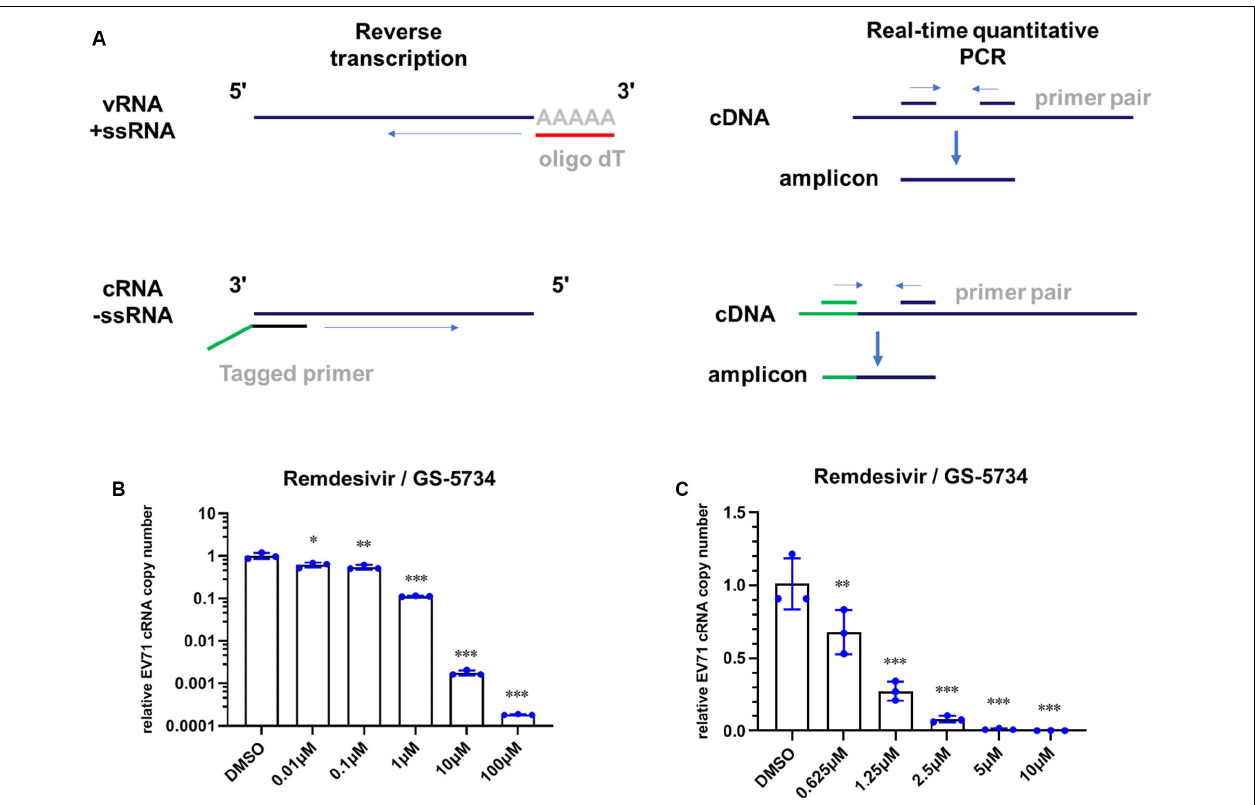
FIGURE 3 | Remdesivir inhibits EV71 replication at the viral transcription stage. (A) Schematic representation of reverse transcription and PCR protocol for conventional real-time PCR (top) and tagged primer-mediated qRT-PCR (bottom). The tag within the tagged RT primer is shown in green, and the amplified products contained a portion of the tag and cDNA. (B,C) Synthesis of EV71 cRNA (normalized to the actin expression level) was inhibited by remdesivir (mean ± SD, n = 3). P > 0.05, * P < 0.05, ** P < 0.01, and *** P <